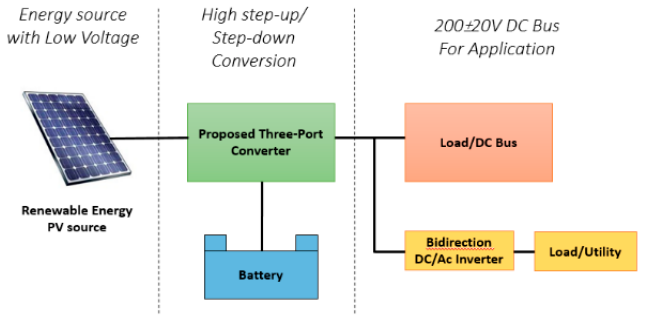
Figure 1. Application diagram of three-port bidirectional converter.